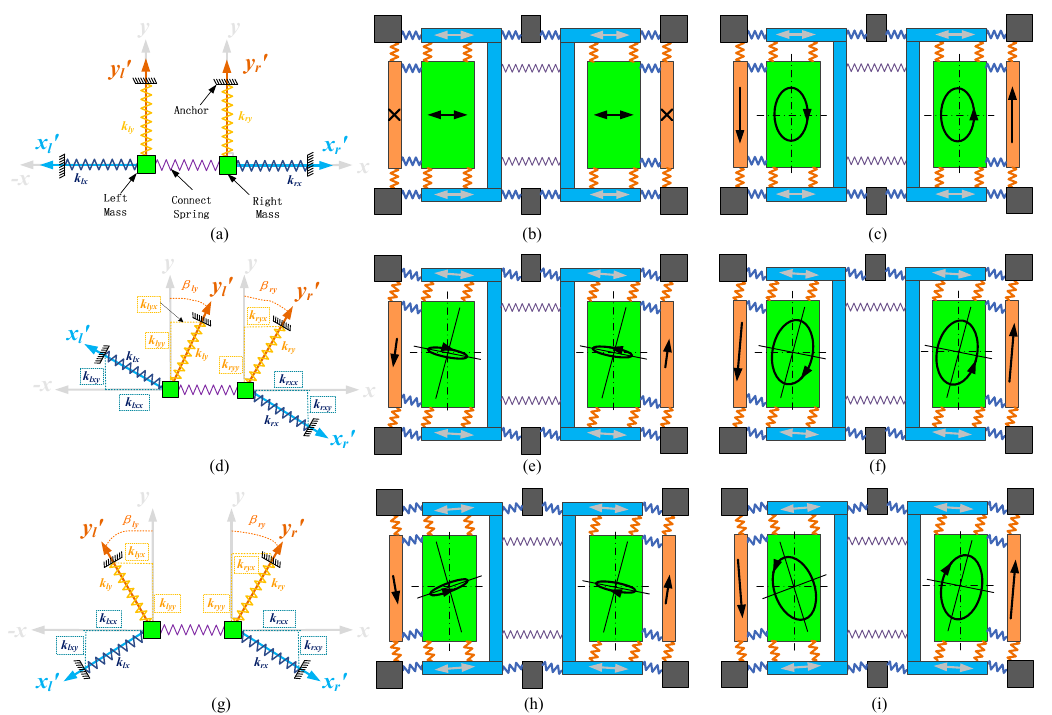
Figure 3. ( a ) Stiffness system of ideal dual-mass gyro structure; ( b ) Ideal structure movement without angular rate input; ( c ) Ideal structure movement with constant angular rate input; ( d ) Stiffness system with in-phase quadrature error angular structure; ( e ) The movement of in-phase quadrature error angular structure without angular rate input; ( f ) The movement of in-phase quadrature error angular structure with constant angular rate input; ( g ) Stiffness system with anti-phase quadrature error angular structure; ( h ) The movement of anti-phase quadrature error angular structure without angular rate input; ( i ) The movement of anti-phase quadrature error angular structure with constant angular rate input.